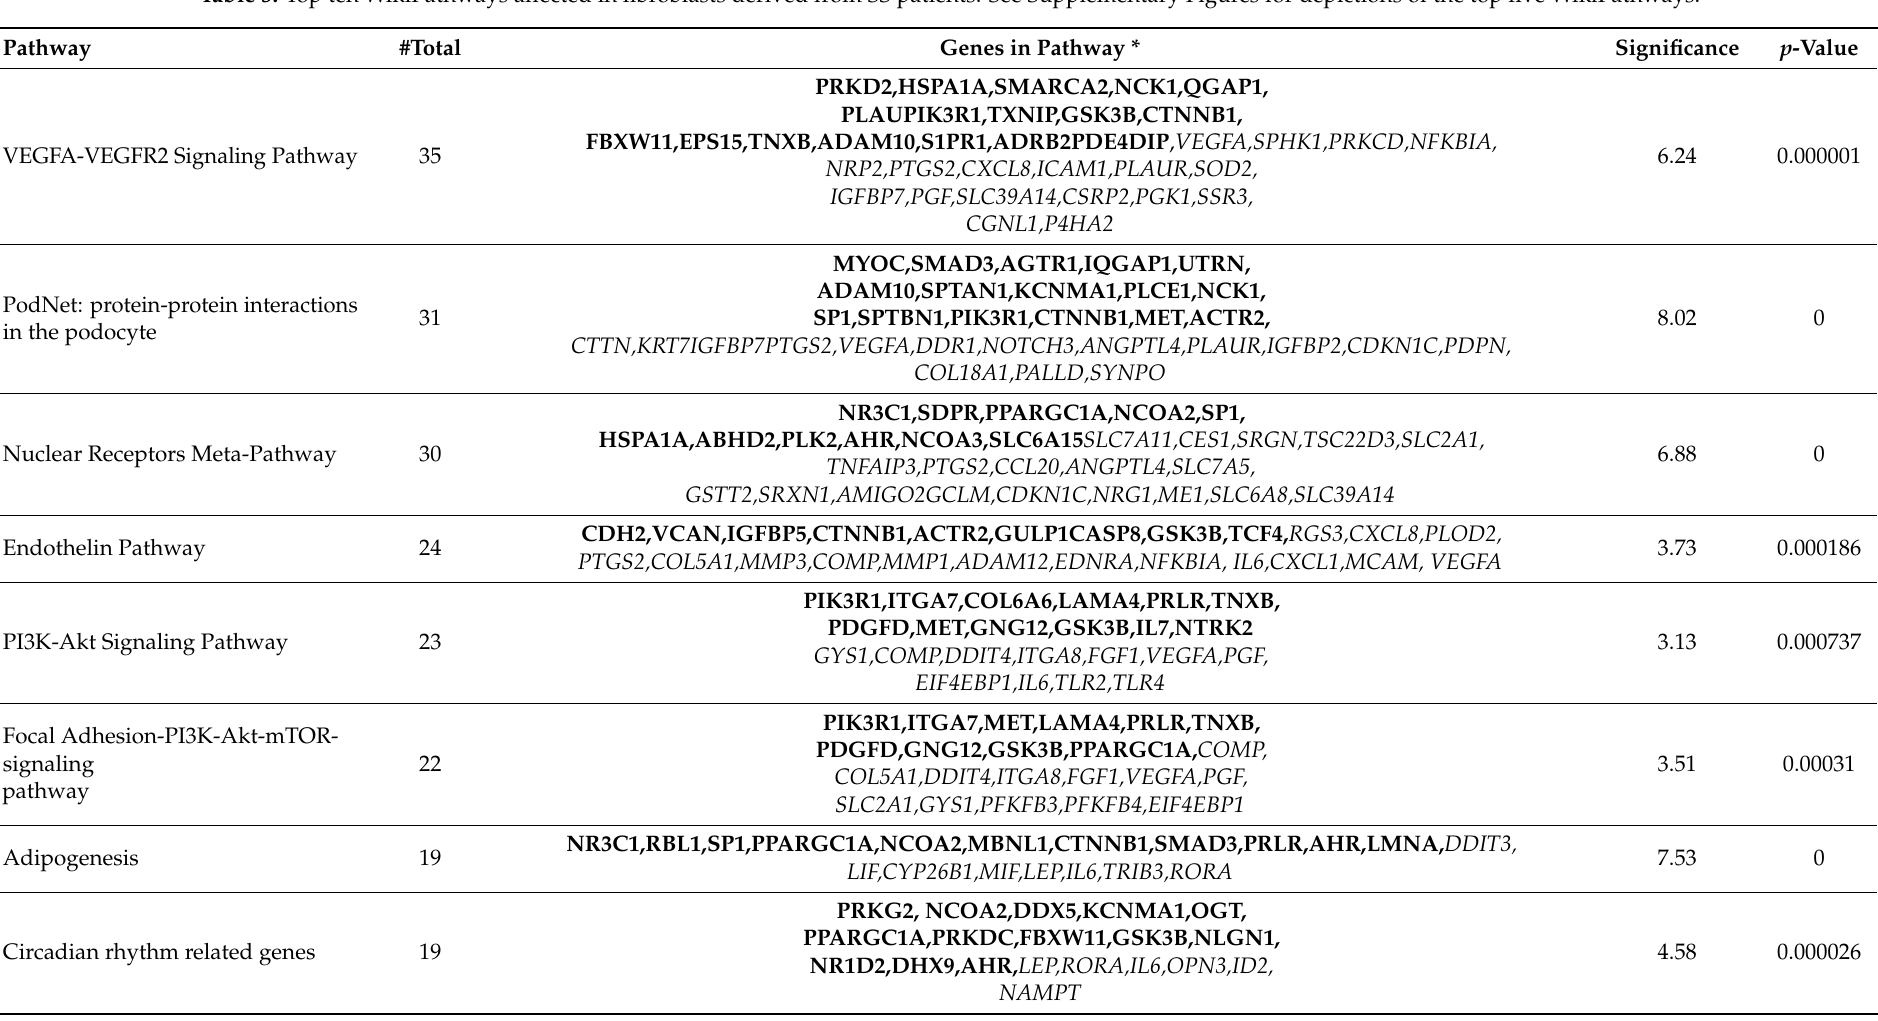
Table 3. Top ten WikiPathways affected in fibroblasts derived from SS patients. See Supplementary Figures for depictions of the top five WikiPathways. Pathway